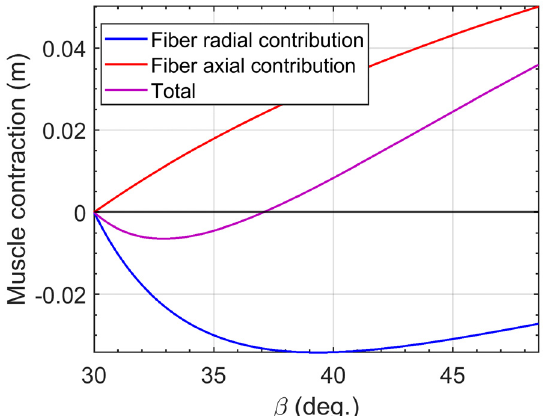
Figure 7. Variation in fiber radial and axial contributions to total muscle contraction with fiber pennation angle for a β i = 30 ◦ bundle with fiber contact boundary